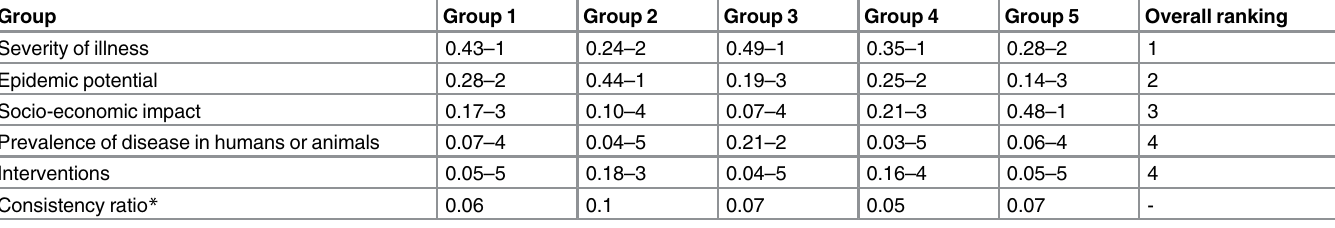
Table 2. Ranking of criteria using analytical hierarchical process: criteria weight and rank for each of the groups.